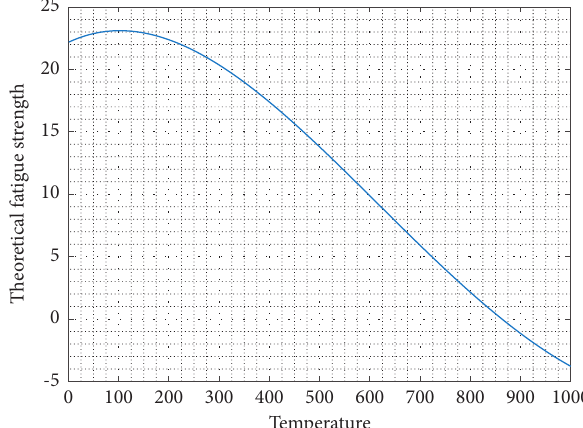
Figure 11: Theoretical fatigue strength v/s theoretical UTSe for dissimilar